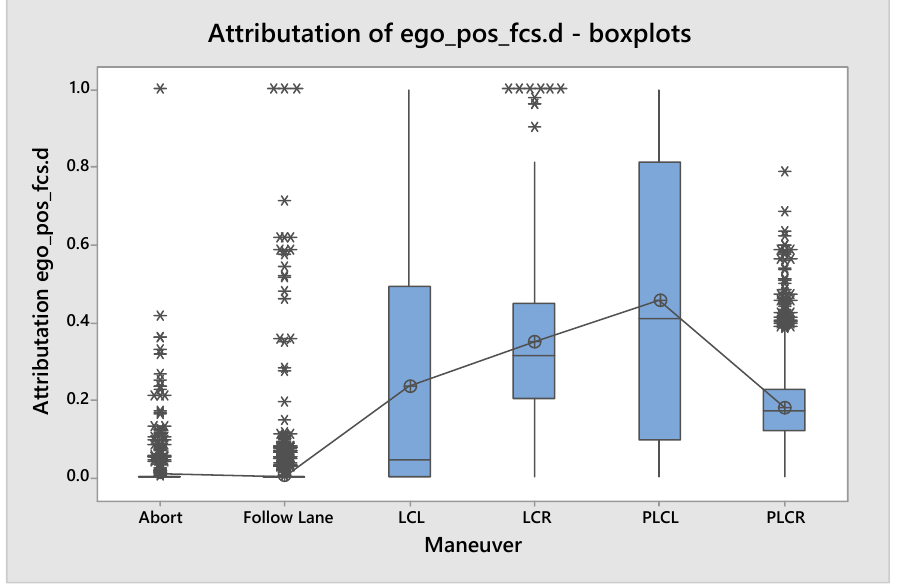
Figure 3. Distributions of attributation values for one of the ego parameters (distance from the center of lane) for all maneuver